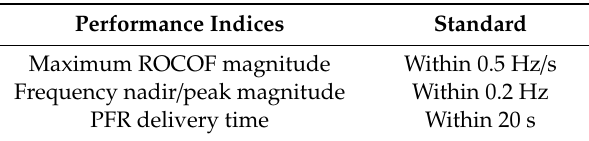
Table 4. Predetermined standards of performance Table 5. Parameters in simulation.